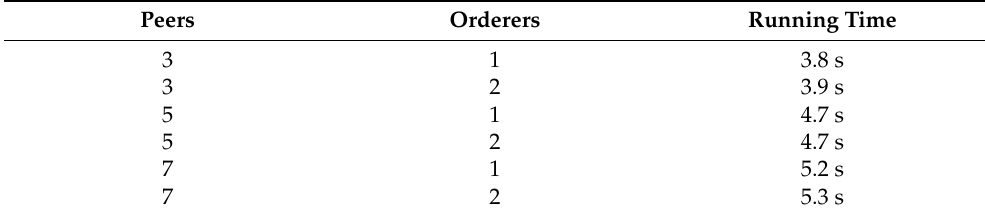
Table 3. Performance analysis of block creation.